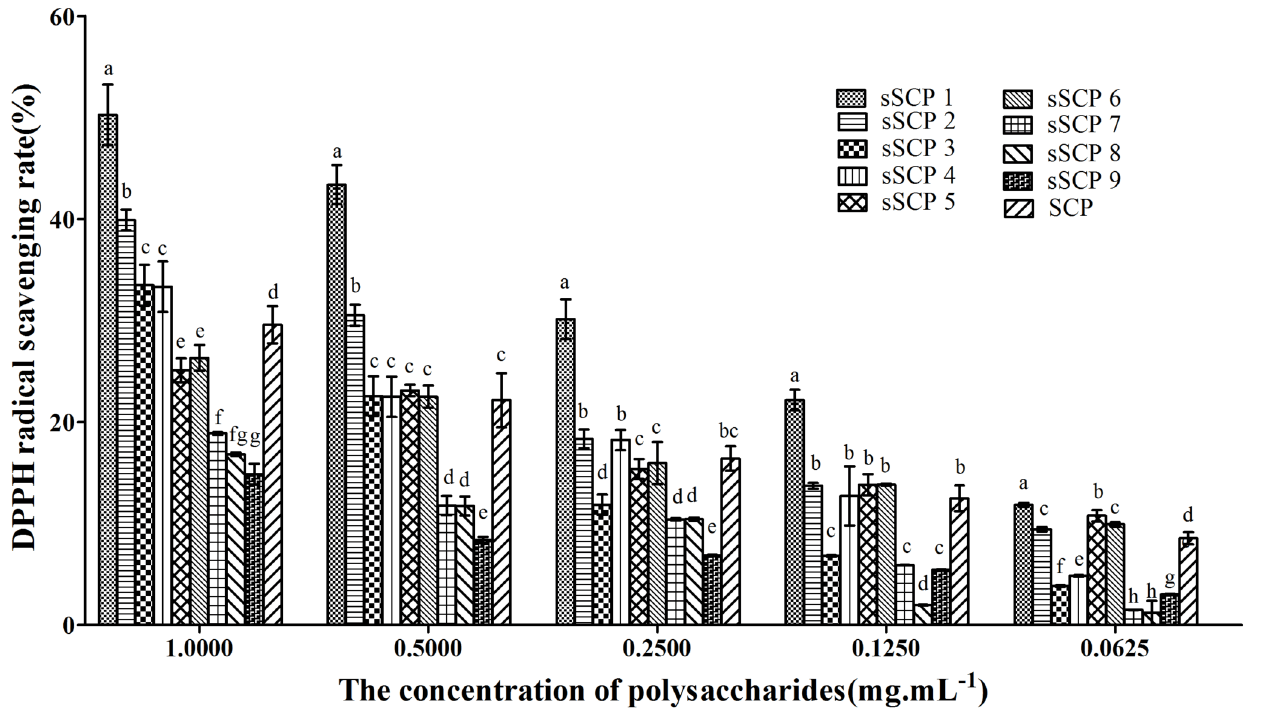
Fig 2. The DPPH radical-scavenging rates in each group at five concentrations. Bars in same concentration without same superscripts (a – h) differ significantly ( P < 0.05).